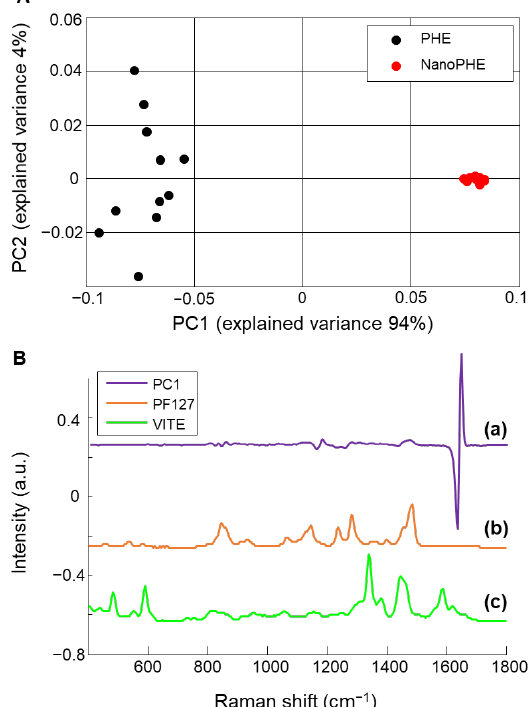
Figure 3. ( A ): PCA Scatter plot from reference spectra of free (black) or NanoPHE (red). ( B ): Loading 1 from the PCA ( a ) compared to the reference spectra of Pluronic ® F127 ( b ) and vitamin E ( c ). Spectra are offset for clarity.